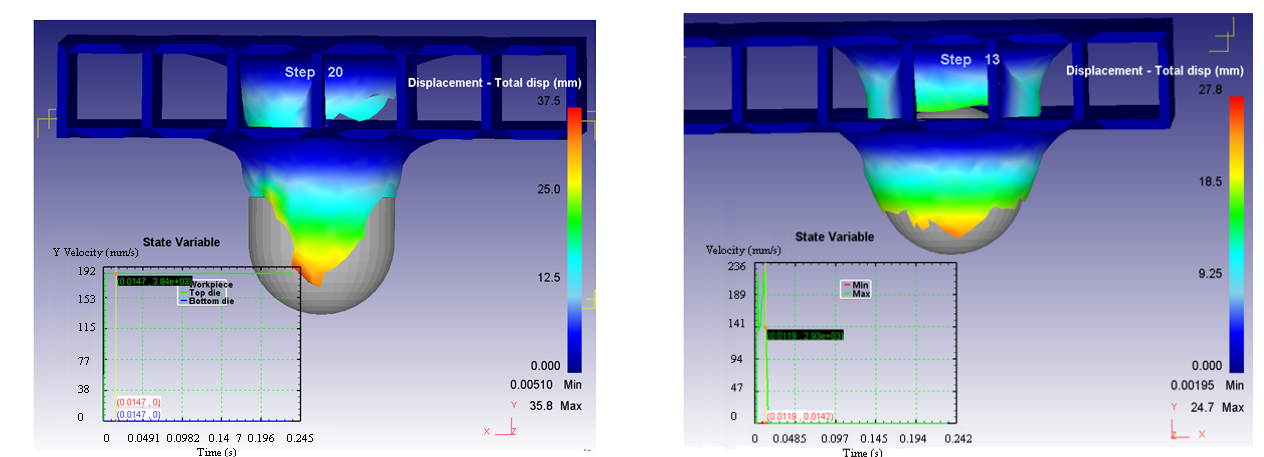
trated in Figure 17. Figure 17.